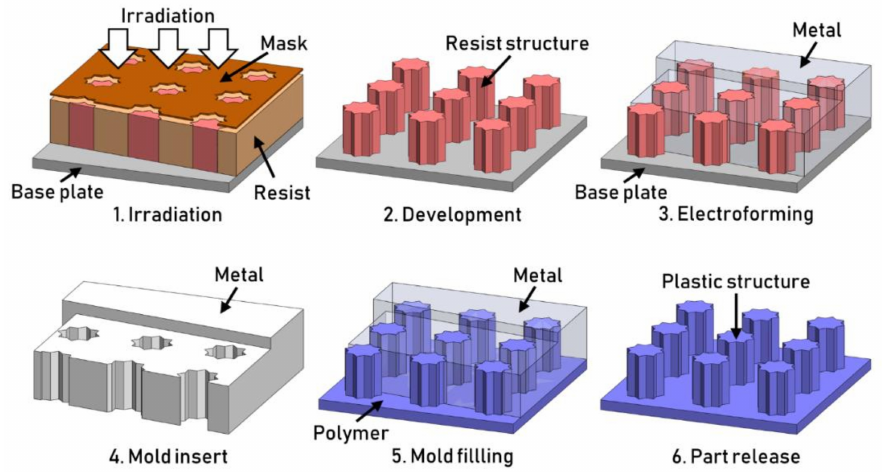
Figure 12. LIGA technique working principle and manufacturing steps.